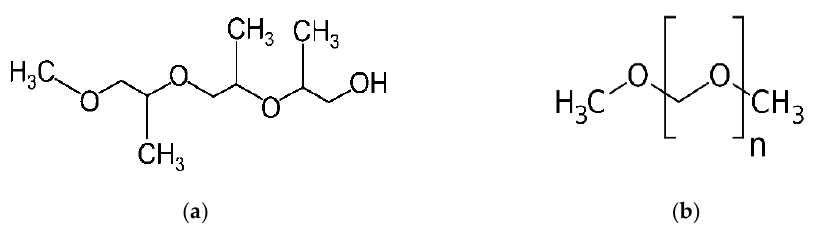
Figure 1. Chemical structures of additives used: ( a ) tripropylene glycol methyl ether (TPGME), ( b ) polyoxymethylene dimethyl ethers (OMEs).